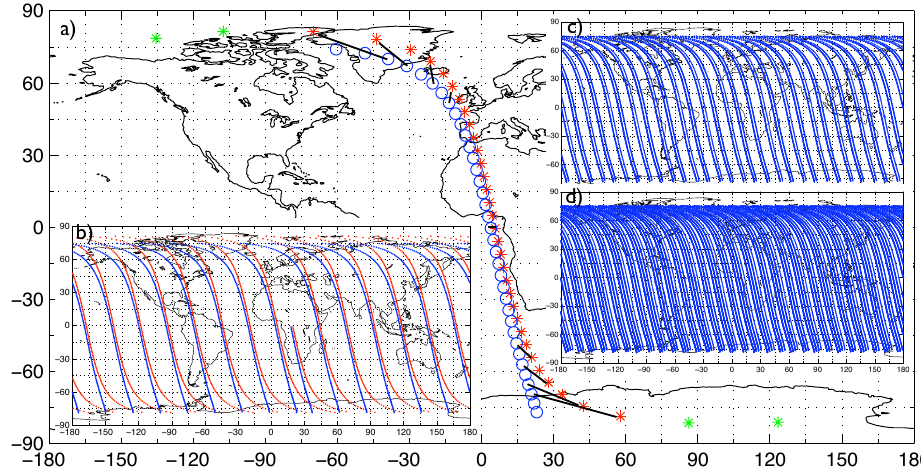
Fig. 1. (a) An example of the field-of-view (FOV) ground tracks for OCO for 21 March: 100 min of measurements for nadir pointing mode (asterisks) and glint (circles). Black lines connect nadir and glint FOVs at same time. The maximum SZA is taken as 85 ◦ /80 ◦ for nadir/glint. Green asterisks indicate positions where nadir SZA ≥ 85 ◦ and glint SZA ≤ 80 ◦ . (b) One-, (c) four-, and (d) seven-day coverage for nadir (red) and glint (blue) beginning 21